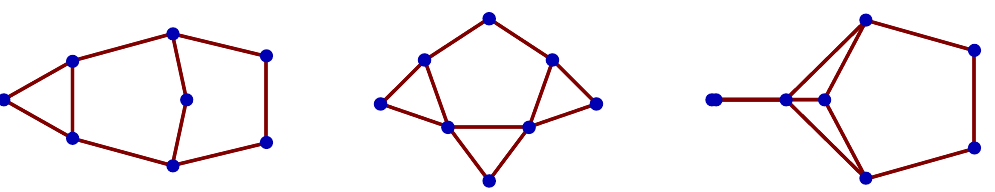
Figure 11 . Representatives from three different not C-equivalent classes of T-equivalent codes, which share the same REP W = ( x + z ) 2 ( x 6 − 2 x 5 z + 3 x 4 z 2 + 4 x 3 y 2 z + x 2 y 4 + 2 x 2 y 2 z 2 + 4 x 2 z 4 + 2 xy 4 z + 24 xy 2 z 3 + 4 xz 5 + 9 y 4 z 2 + 10 y 2 z 4 + 2 z 6 )